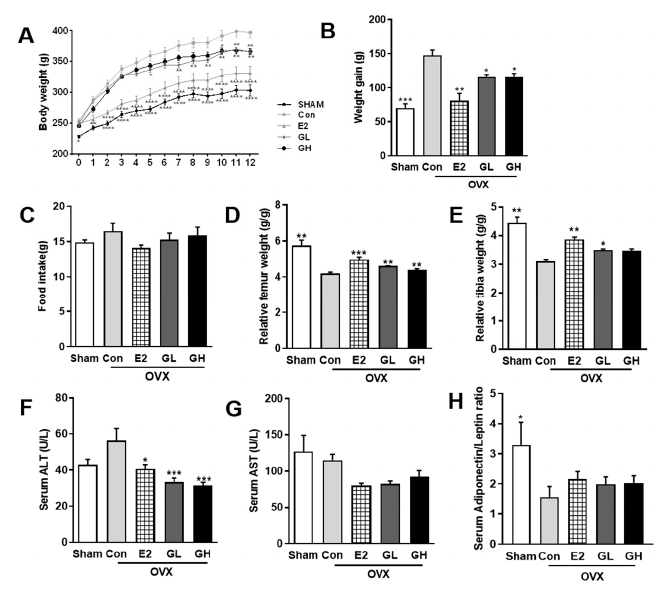
Figure 2. Body and bone phenotype changes in green tomato extract (GTE) supplemented ovariectomized (OVX) rats. ( A ) Weekly body weight measurement during experimental period. ( B ) Total weight gain of OVX rats over 12 weeks. ( C ) Average food intake of 12 weeks. ( D ) Femur weight relative to the total body weight. ( E ) Tibia weight relative to the total body weight. ( F ) Serum aminotransferase (ALT) content. ( G ) Serum alanine aminotransferase (AST) content. ( H ) Serum adiponectin/leptin ratio. Results are expressed as means ± SEM. Con, control. *** p < 0.001, ** p < 0.01, * p < 0.05, significantly different from Con. Table 3. Rats organelle weight.